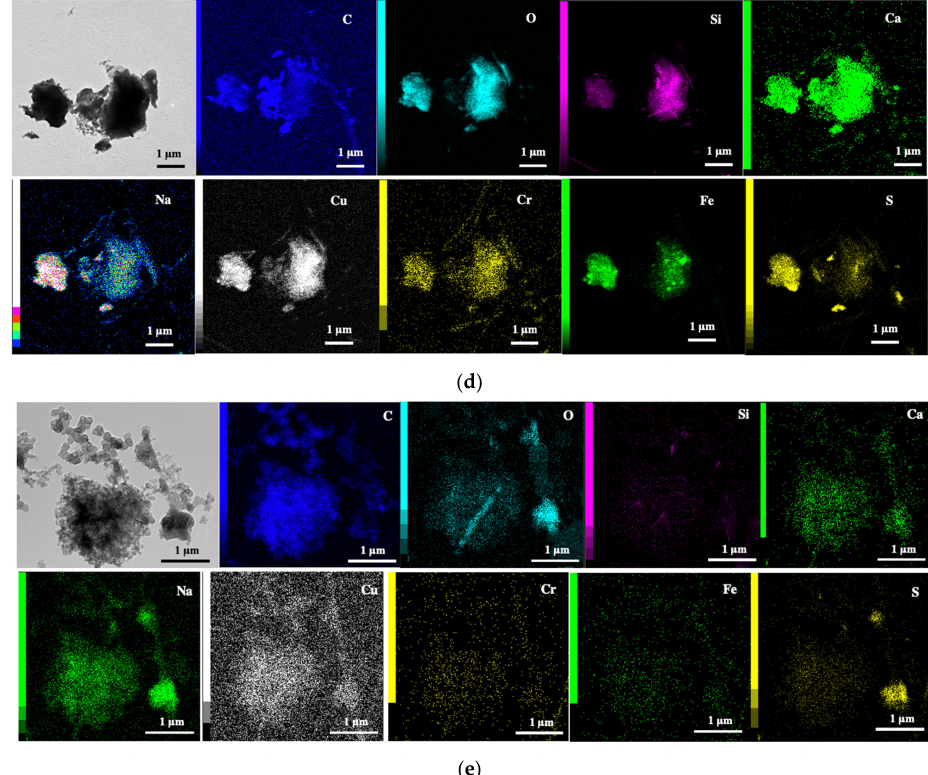
Figure 4. TEM micrographs and EDS elemental mapping analysis of PM10 at ( a ) BK1, ( b ) BK2, ( c ) NP1, ( d ) NP2, and ( e ) NB sampling sites.